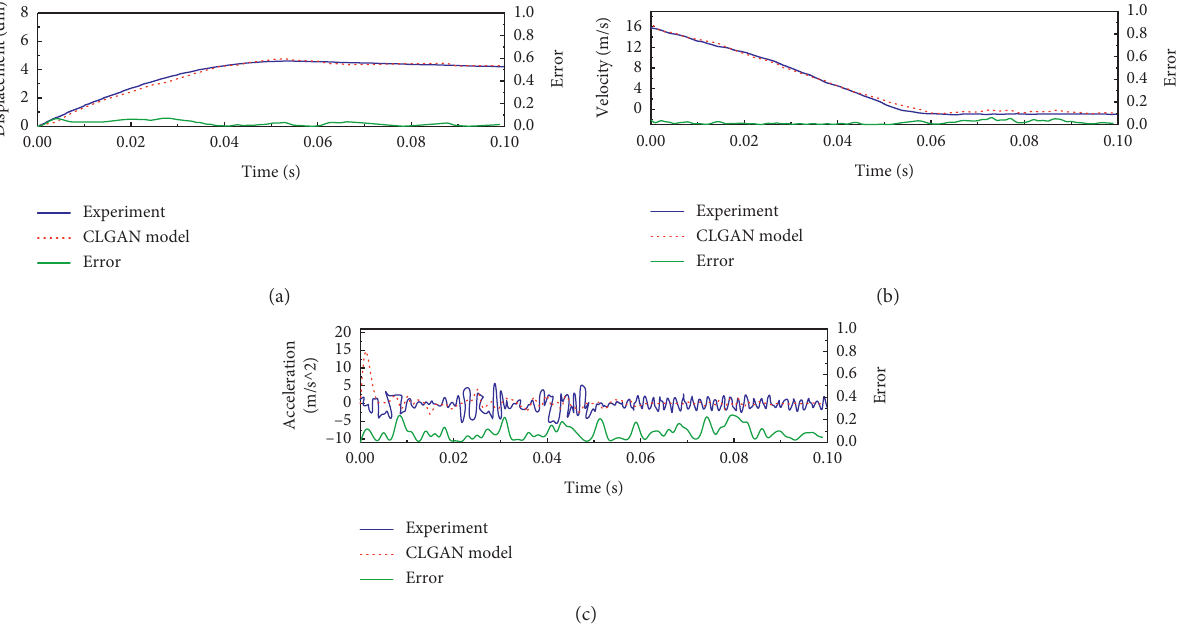
Figure 15: Comparison of the anticlimbing device’s crash dynamic characteristics. (a) Displacement comparison of CLGAN model and experiment results. (b) Velocity comparison of CLGAN model and experiment results. (c) Acceleration comparison of CLGAN model and experiment results.